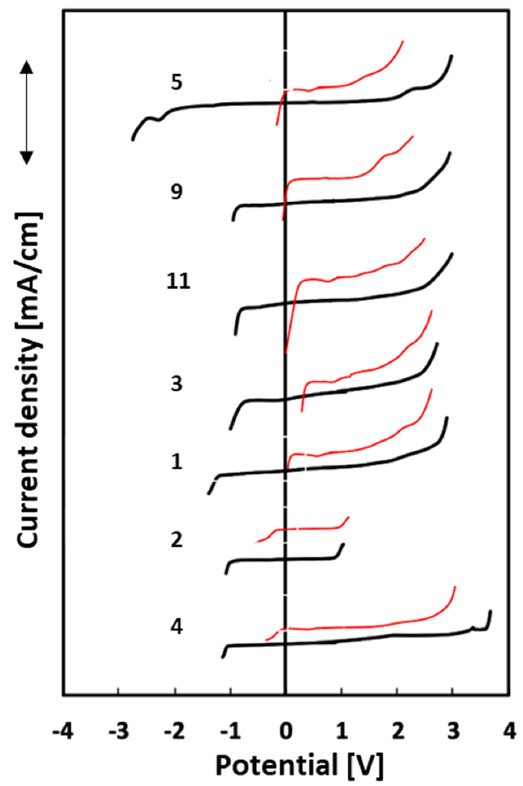
Figure 4. Electrochemical stability ranges for 7 ionic liquids: platinum electrode (Pt)—red lines, glass-like carbon electrode (GC)—black lines.